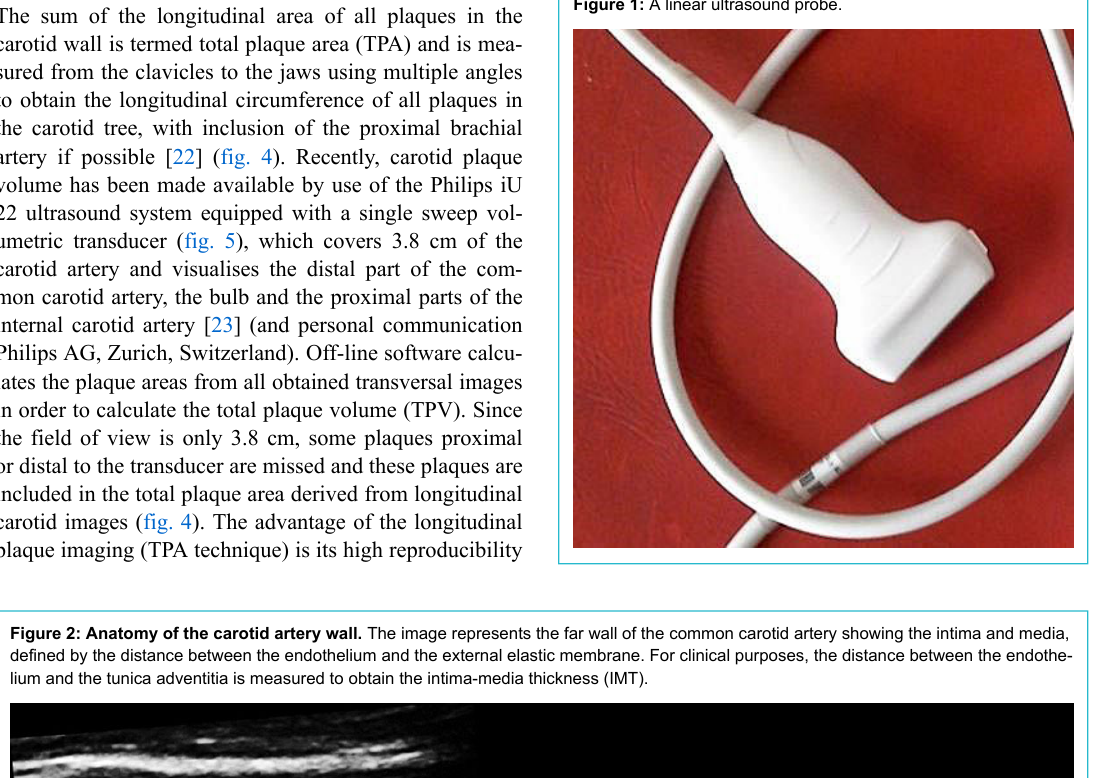
Figure 1: A linear ultrasound probe.